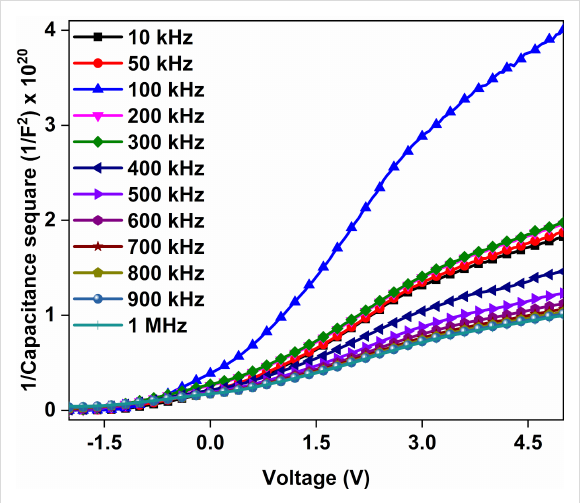
Figure 11: C − 2 – V plots of the Au/CuNiCoS 4 /p-Si photodiode for in- creasing frequencies.